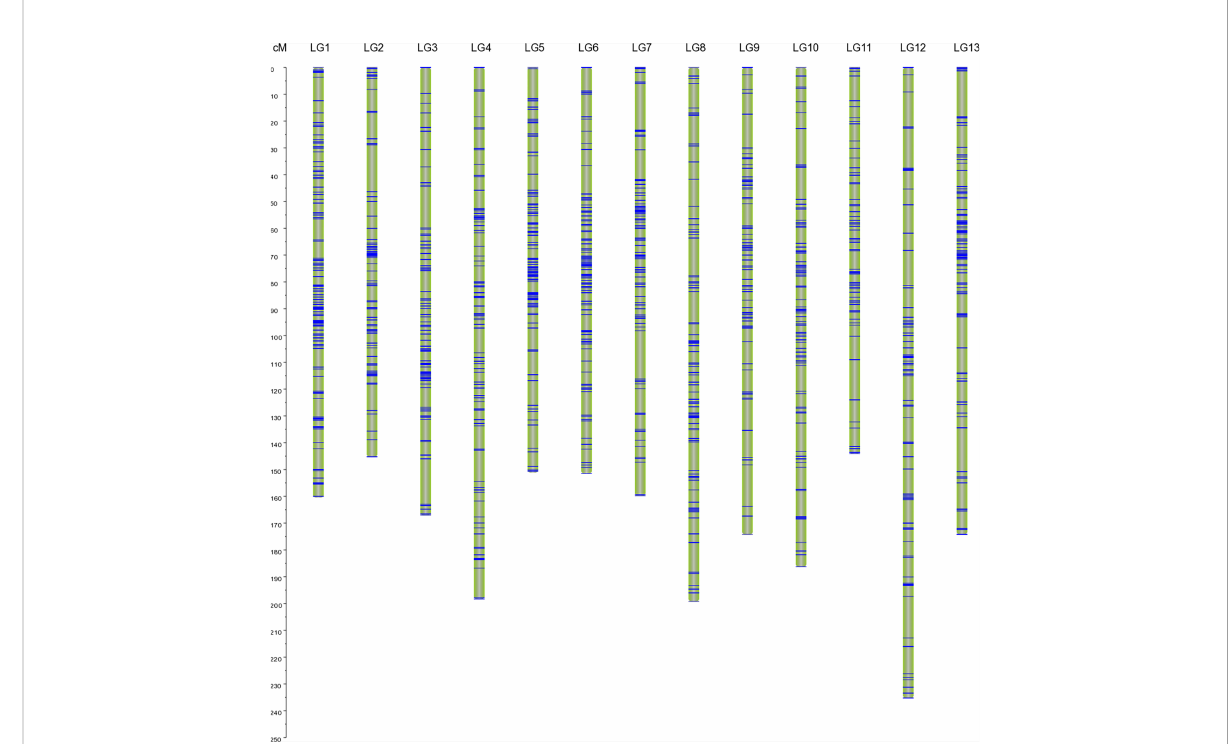
FIGURE 1 An interspeci fi c high-density genetic linkage map of Luffa with 13 linkage groups. Single nucleotide polymorphism (SNP) markers are highlighted with blue lines on each linkage group